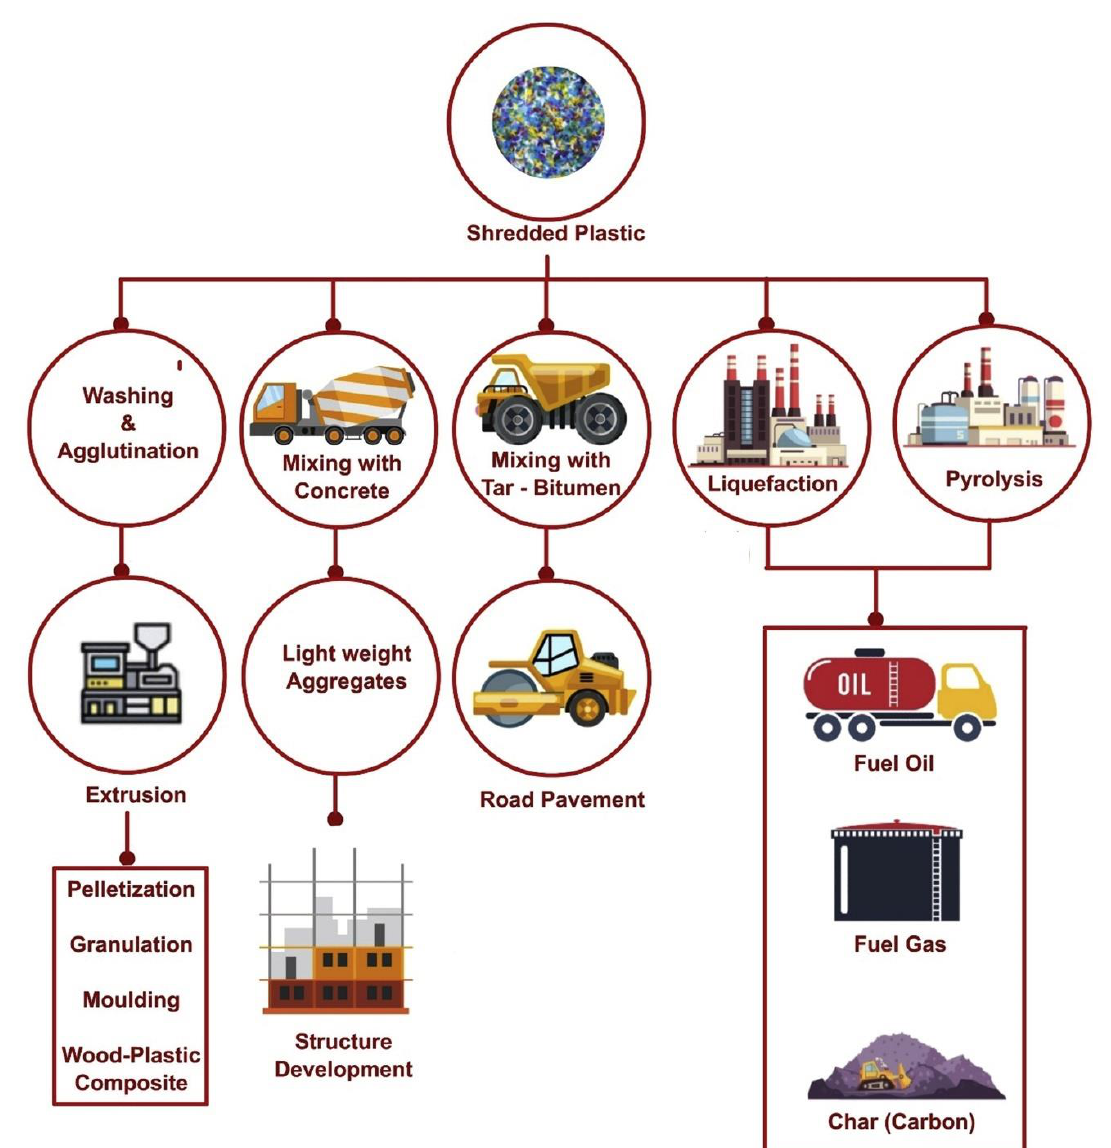
Figure 14. Flowchart of various management strategies for shredded plastic [63] .